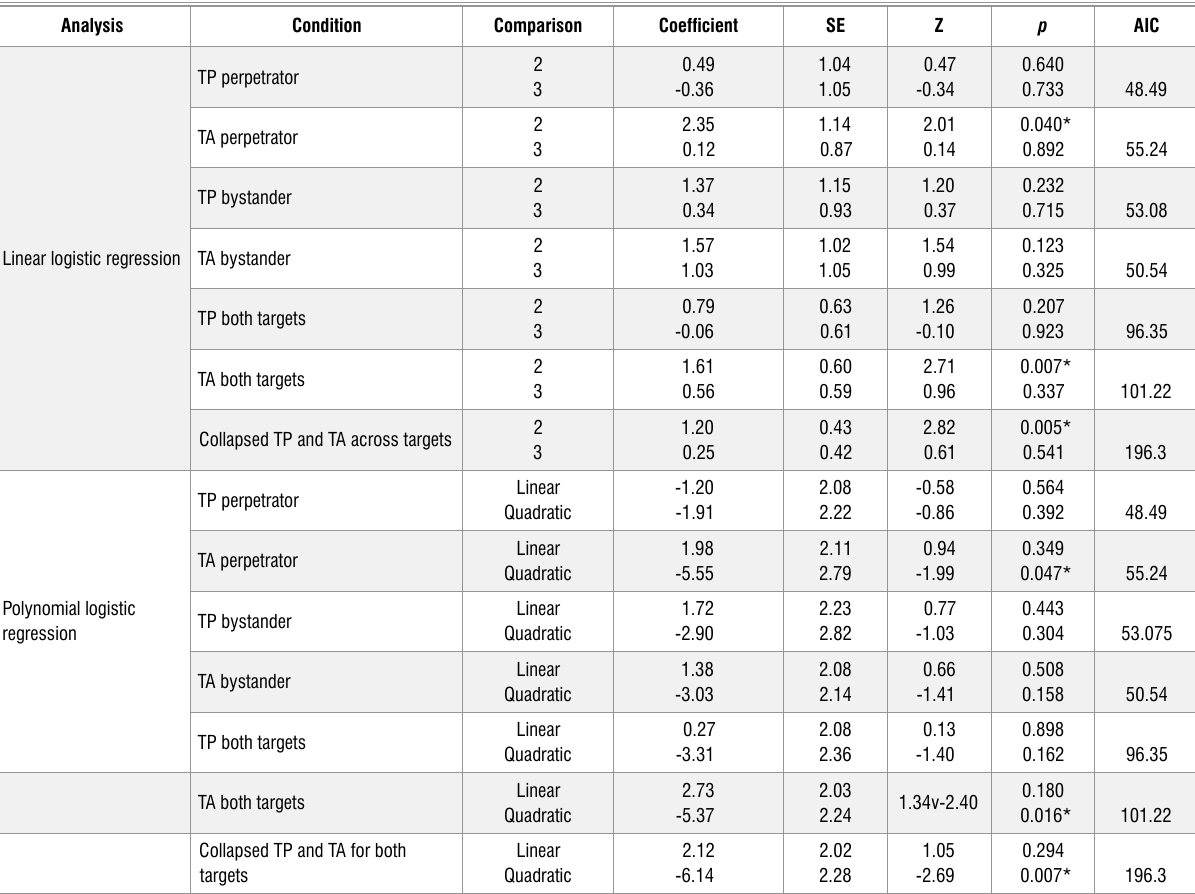
Comparison of linear and non-linear models